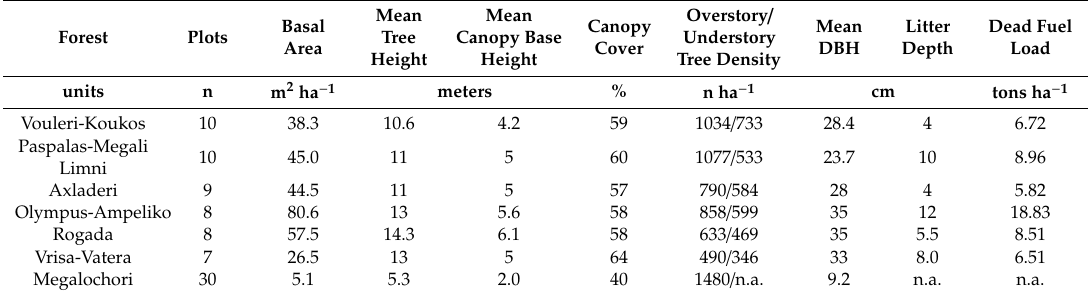
Table 1. Average vegetation and fuel conditions for the seven forests of the study area, as derived from the field inventory on 82 plots. n.a.: not available. Basal area was estimated for the dominant species (Calabrian